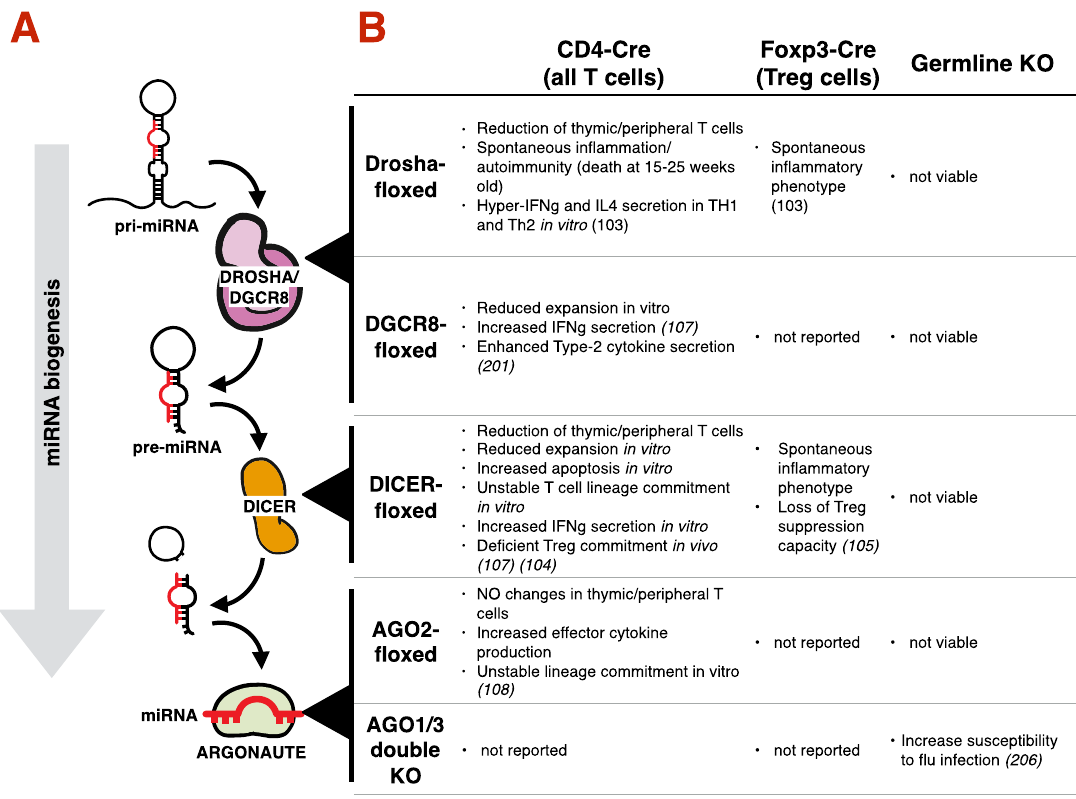
Figure 3. miRNA biogenesis and its impact on T cells function and Type2 immunity. ( A ) An immature RNA strand that contains a typical stem-loop structure (pri-miRNAs) is transcribed by RNA polymerase-II, and subsequently recognized by the RNAse DROSHA, in complex with DGCR8. DROSHA cleaves the pri-miRNA to produce a shorter, pre-miRNA, which is in turn the substrate of the RNase DICER, the enzyme that removes the loop from the structure. A single strand of RNA is then loaded on an Argonaute protein, to produce a mature miRNA. ( B ) A summary table describes the impact that proteins involved in the maturation miRNAs has on T cells and adaptive immunity. The first column indicates the floxed gene. The first row indicates the promoter (and the cell type) that drives Cre expression that lead to gene deletion in a specific cell subset in mice.